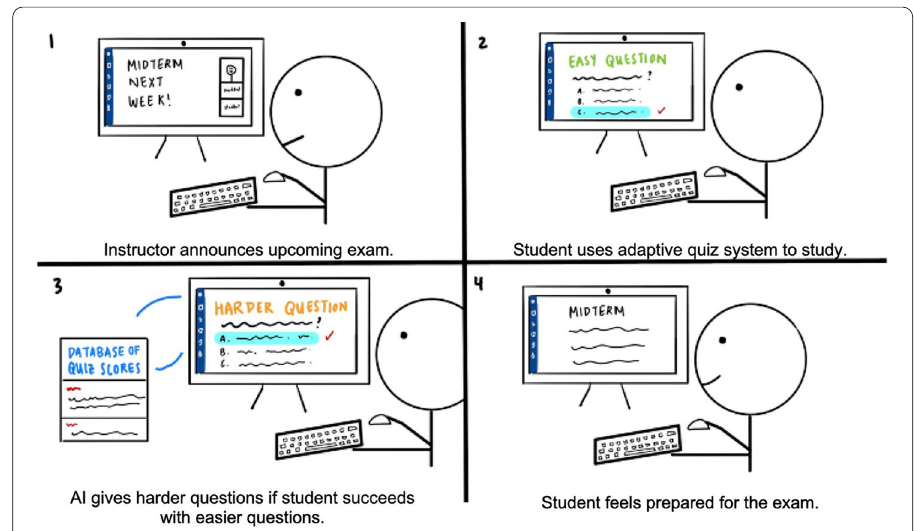
Fig. 1 A storyboard example of scenario 8, Adaptive Quiz in Table 2